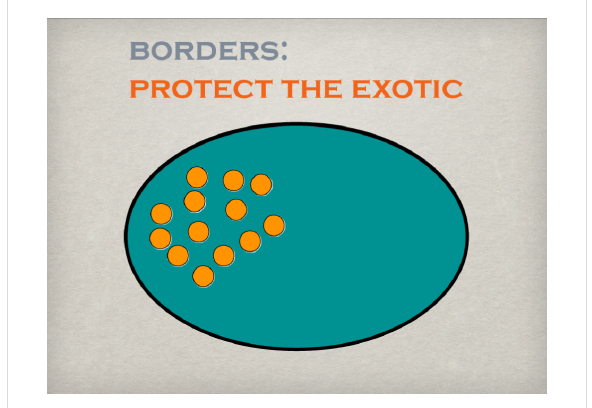
Figure 8: Borders separating a space from the surrounding may serve as a protective cover allowing for developments without external pres- sure or